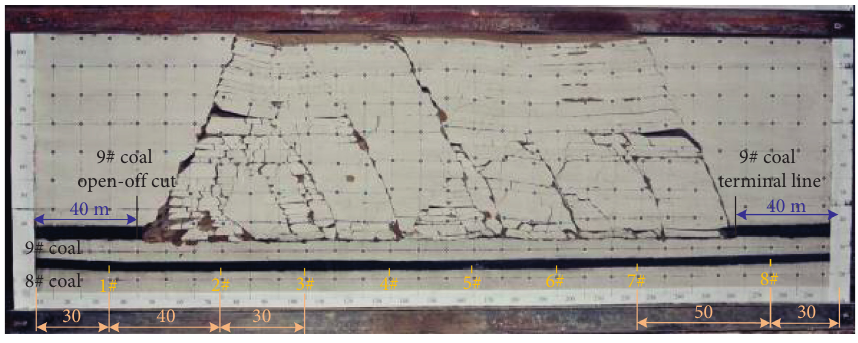
Figure 21: Model diagram after excavation of similar simulation